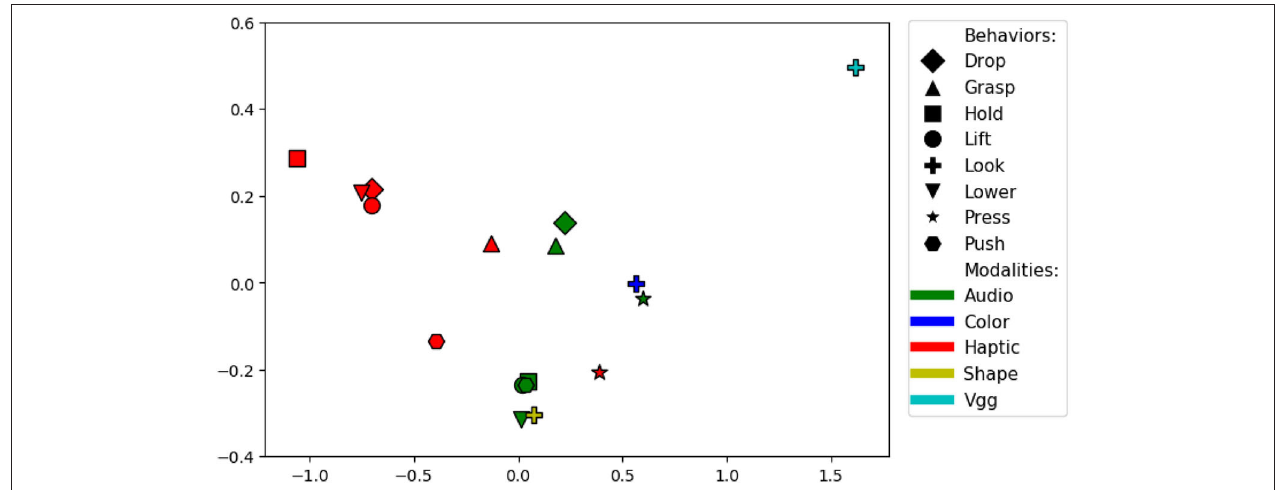
FIGURE 24 | Two dimensional ISOMAP embedding of the accuracy delta matrix for the dataset in Sinapov et al. (2016). Each point represents a sensorimotor context (i.e., a combination of a behavior and sensory modality). Points close in this space represent contexts between which information can be transferred